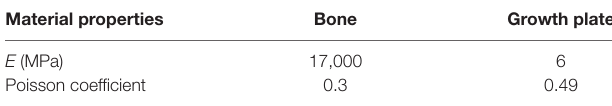
TaBle 1 | Material properties of bone and cartilage.